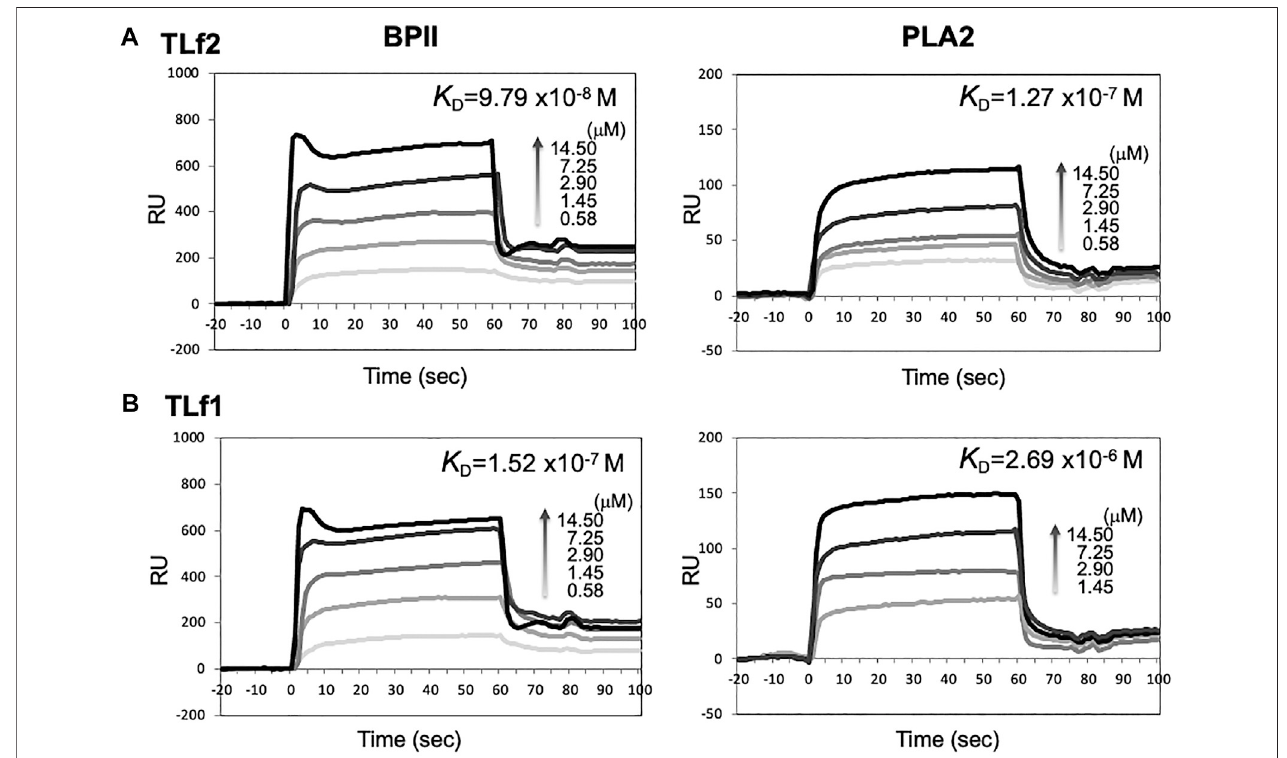
FIGURE6| SPRsensorgramsofBPII (left) and[Asp49]PLA2 (right) bindingtoimmobilizedTLf2 (A) andTLf1 (B) ,respectively.Surfaceplasmonresonance(SPR) weremeasuredtodeterminetheinteractionbetweenTLfsandPLA2sbyusingBIAcoreX.Puri fi edTLf2andTLf1wereimmobilizedtoCM5sensorchip,respectively,and BPII and [Asp49] PLA2 were injected as analytes (12.5 – 100 μ g/ml) at a fl ow rate of 20 μ L/min. Sensorgrams were analyzed using nonlinear least squares curve fi tting with BIAevaluation software.